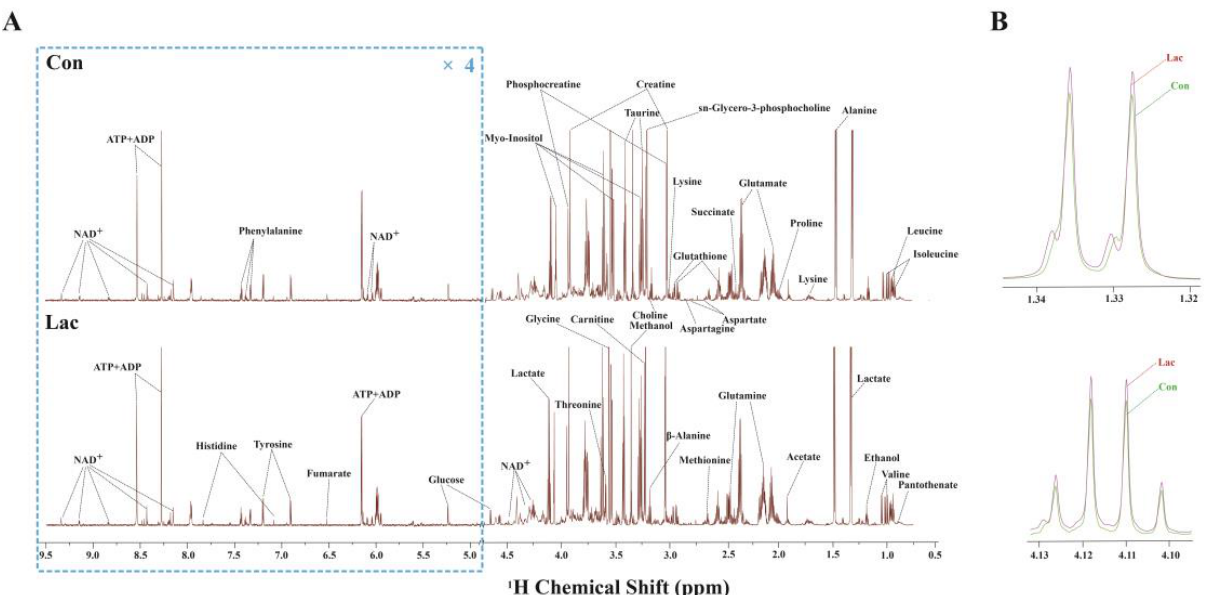
Figure 4. Typical 1D 1 H spectra of aqueous extracts derived from the two groups of myoblasts. ( A ) 1D 1 H spectra of controls (Con) and lactate-treated cells (Lac) were recorded on an 850 MHz NMR spectrometer at 25 ◦ C. Vertical scales are kept constant in all the spectra, and the resonance region of water (4.75–4.85 ppm) was removed. For the purpose of clarity, the resonance region of 4.85–9.5 ppm has been magnified four times compared with the other region of 0.75–4.75 ppm. Abbreviations: NAD + , nicotinamide adenine dinucleotide; AXP, adenine mono/di/triphosphate; and ( B ) amplified resonance regions of lactate in Con cells (green) and Lac cells